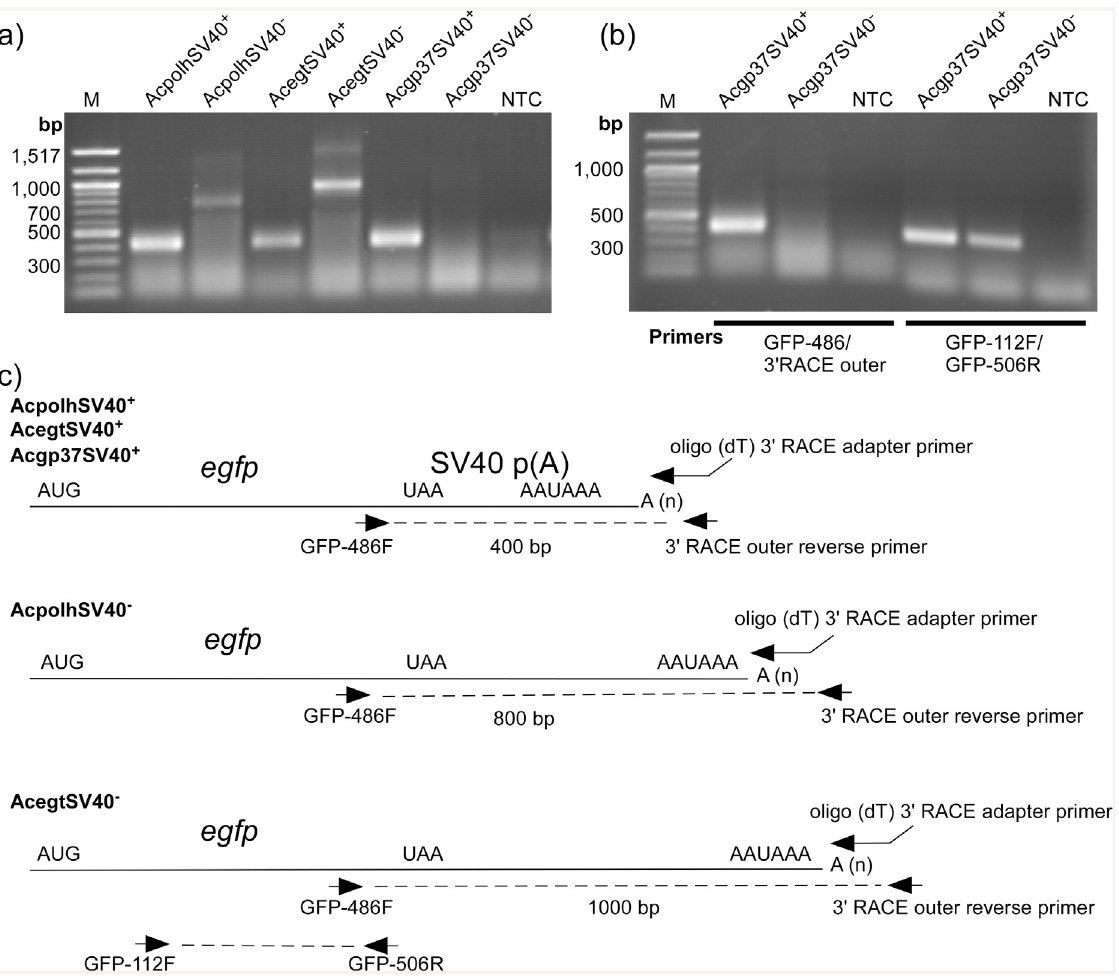
Fig 4. Analysis of untranslated regions of transcripts of viral constructs with or without the SV40 polyA signal in Sf21 cell infection. A . 3 ’ RACE analysis of egfp gene transcripts. An oligo (dT) 3 ’ RACE adapter primer was used to synthesize cDNA from total RNA isolated from the Sf21 cells infected with different viruses at 48 h p. i. A pair of primers (GFP-486F/3 ’ RACE outer reverse primer) was used to amplify the 3 ’ ends of the egfp transcripts by PCR. The PCR products were separated by agarose gel electrophoresis. B . RT-PCR confirmation of the presence of polyadenylated egfp mRNA initiated from the polh promoter at the gp37 locus of AcMNPV. NTC, no-template control. M, DNA size marker. C . Schematic of egfp gene 3 ’ RACE analysis. Dotted lines indicate 3 ’ RACE products depicted from A